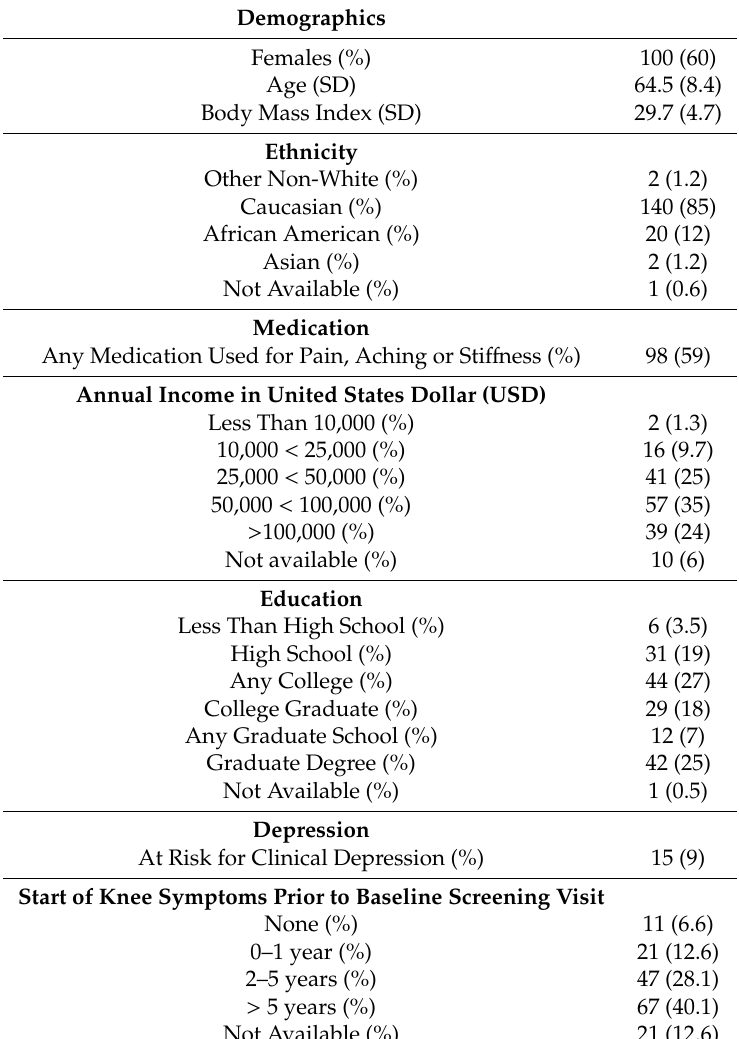
Table 1. Baseline demographic data of the 165 participants included in this investigation. Information not known or unwilling to give by the participants during the screen visits were classified as not available. Values are given as quantity with the respective percentage of the total sample (%) or as means with standard deviation